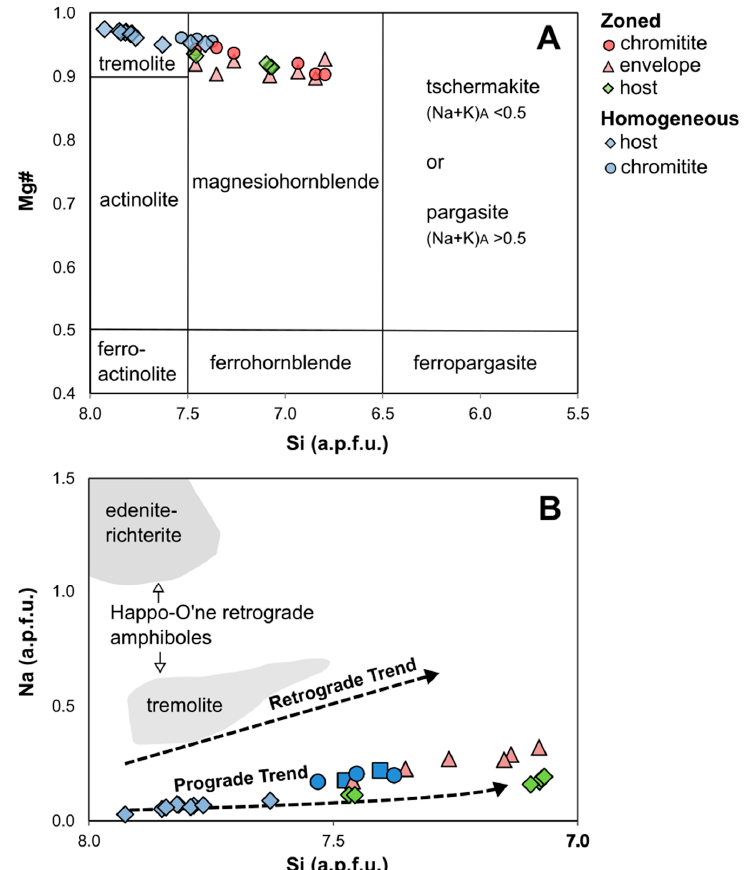
Figure 7. ( A ) Classification of amphibole based on Si atoms per formula unit (a.p.f.u.). and Mg# [39]; ( B ) Si a.p.f.u. vs. Mg# of tremolites and amphiboles from Ulamertoq samples. Prograde and retrograde trends of tremolites are from the study of Nozaka in the Happo ultramafic complex [40]. Retrograde amphibole fields are from the study of Khedr and Arai [35].